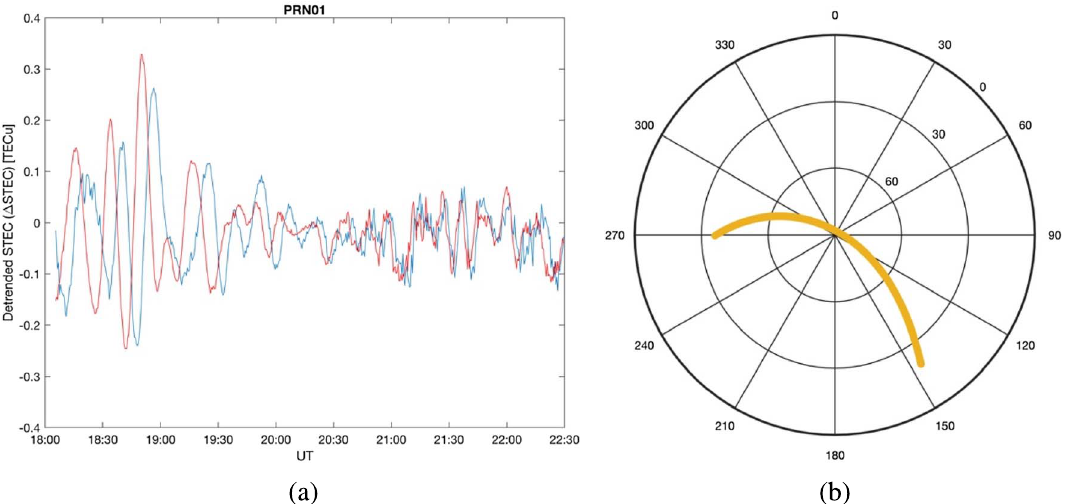
Fig. 14. Example of a satellite-station pair. (a) PRN01 as observed on 18 August 2013 from Dentergem (DENT, blue line) and Bruxelles (BRUX, red line), both in Belgium, with baseline oriented from WNW to ESE. (b) Azimuth/elevation plot for PRN01 as observed from